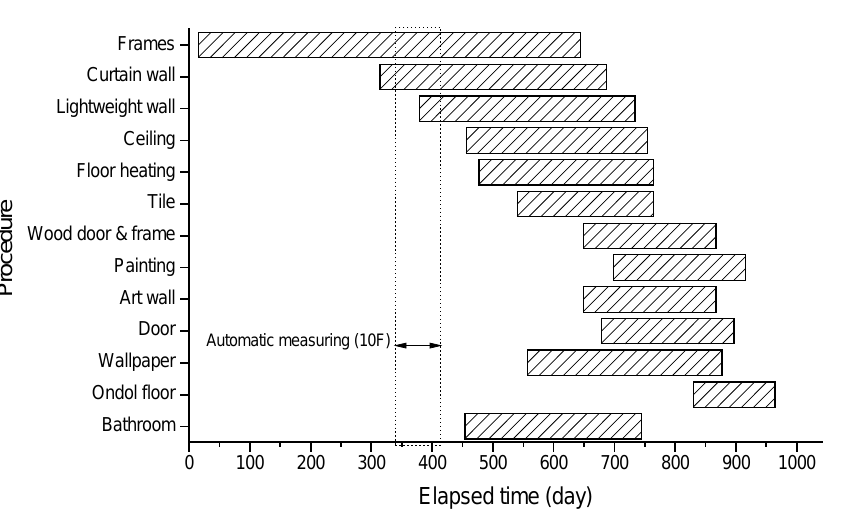
Figure 12. As-built construction schedule for tower